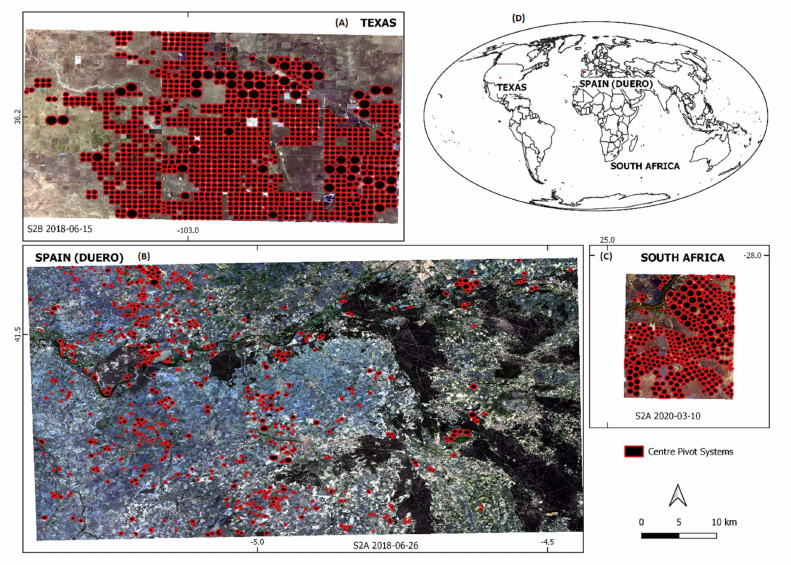
Figure 1. Maps showing the three selected study areas (( A ) Texas, ( B ) the Spanish Duero Basin, and ( C ) South Africa) and their geographic location on the globe ( D ). For each study area, the manually mapped center pivot systems (CPSs) are displayed in red, and the corresponding Sentinel-2 scene used for U-NET semantic segmentation is shown as an RGB true-color composite. Coordinates are projected in